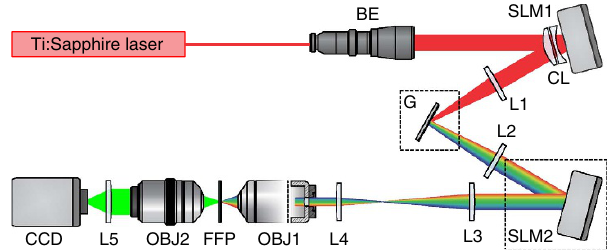
Figure 1 | Experimental set-up for 3D-CGH-TF. The output beam of a Ti:Sapphire laser is magnified using a beam expander (BE) and projected on a first SLM (SLM1). SLM1 modulates the beam’s phase so that light forms a user-defined intensity pattern on the diffraction grating (G) after passing through lens L1. The first diffraction order is collimated by the lens L2 and directed on a second SLM (SLM2). SLM2 imprints a lens-phase modulation that enables precise axial positioning of the spatiotemporal focal plane. The laser beam is then relayed and scaled by lenses L3 and L4 to the excitation objective (OBJ1) pupil size. OBJ1 is mounted on a piezo positioner so that it focuses and axially scans the excitation beam across a thin fluorescent layer. A second objective (OBJ2), always focused on the fluorescent layer, collects emitted fluorescence and forms an image on a CCD camera. Two cross-oriented cylindrical lenses (CL), with focal lengths of equal power and opposite sign, are used to suppress the zero-order spot of the first SLM 64